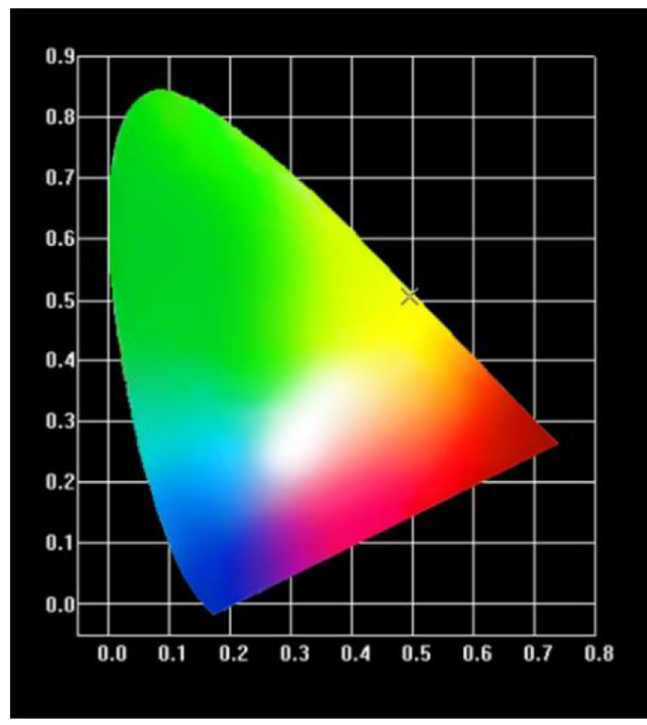
Figure 7. The chromaticity coordinate CIE 1931 of Dy: CYA crystal.